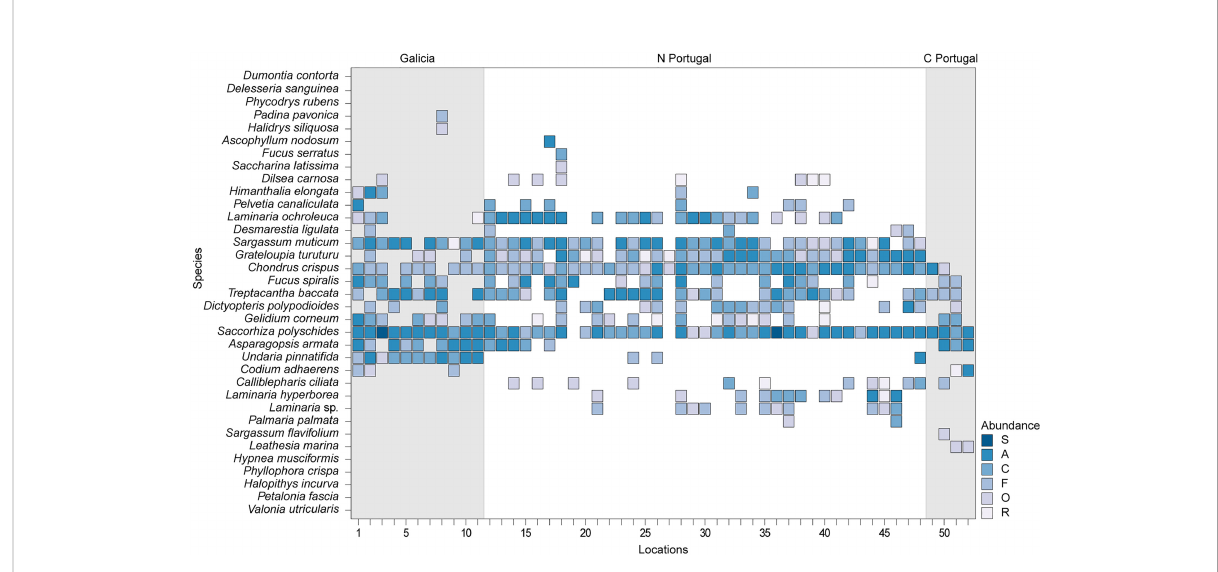
FIGURE 2 Abundance of selected species (y-axis) in North-western Iberia. In the x-axis, locations are identi fi ed by an ID number, from the northernmost (1) to the southernmost site (52). For more details see Supplementary Table 2 . Color gradient indicates abundance based on the SACFOR abundance scale. S, Super Abundant; A, Abundant; C, common; F, frequent; O, occasional; R,